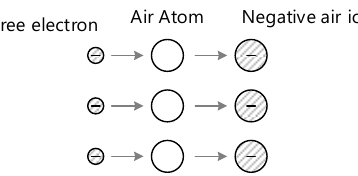
Figure 5. Formation of negative air